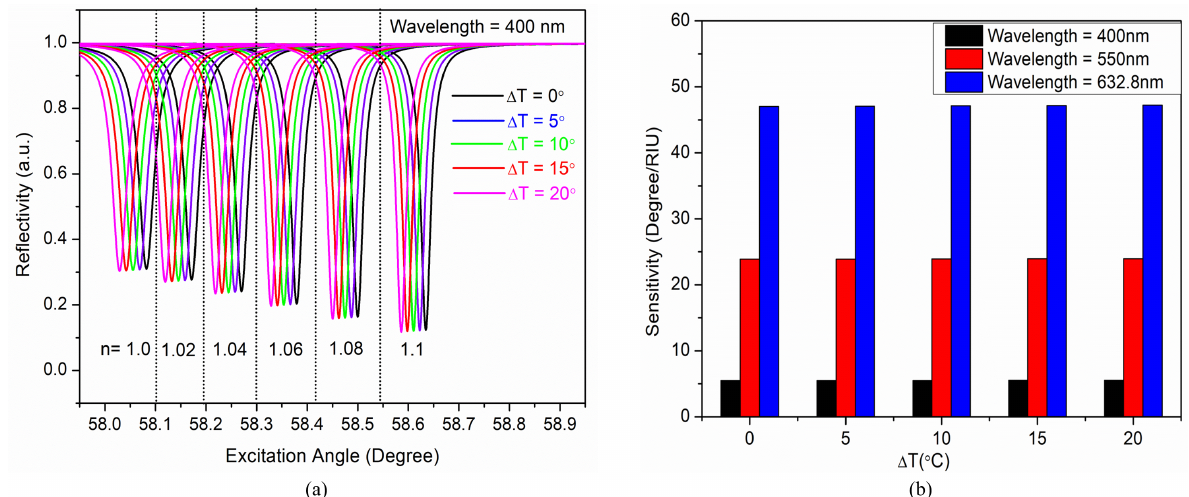
Figure 6. ( a ) Temperature dependent reflectivity spectrum for an incident wavelength on 400 nm at varying infiltrated analyte RI, and ( b ) Comparison of temperature dependent sensitivity analysis at incident wavelengths of 400 nm, 550 nm and 632.8 nm.